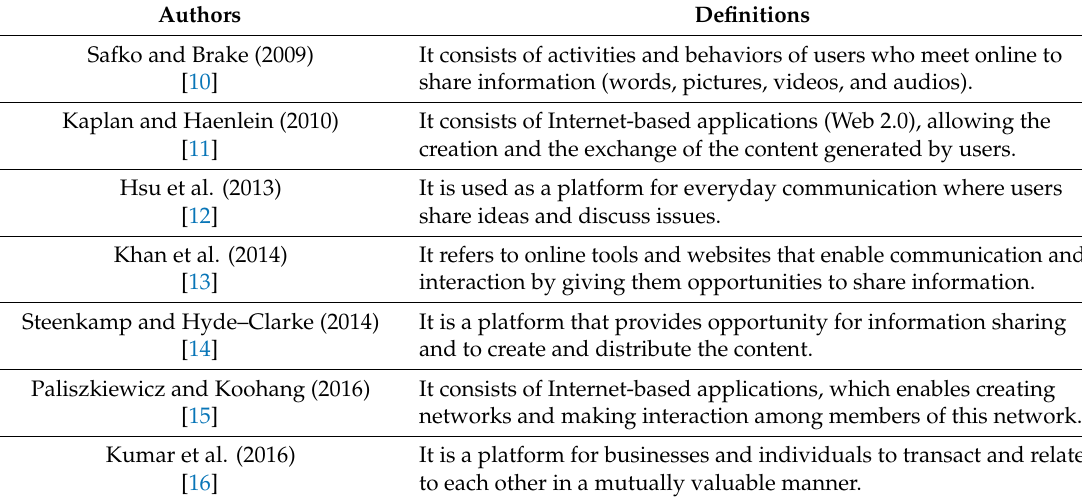
Table 1. Definitions of social